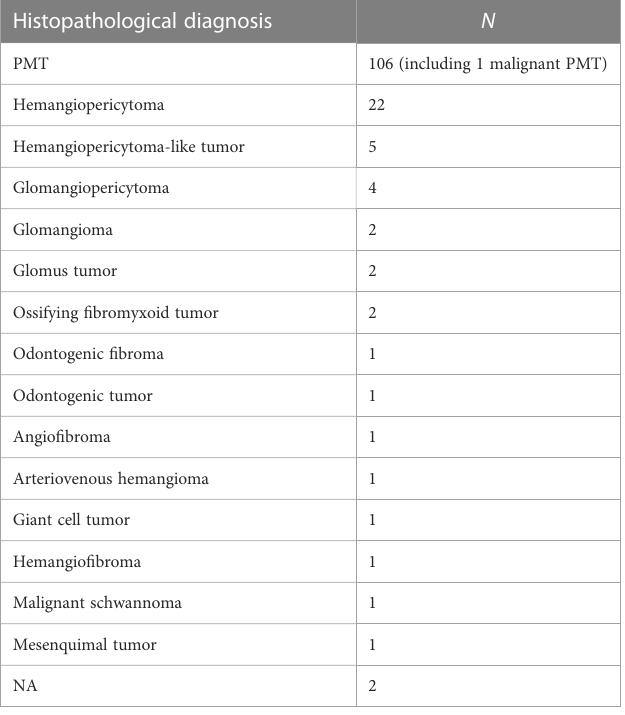
TABLE 4 Histopathological diagnosis of the 153 cases assessed in the present study.